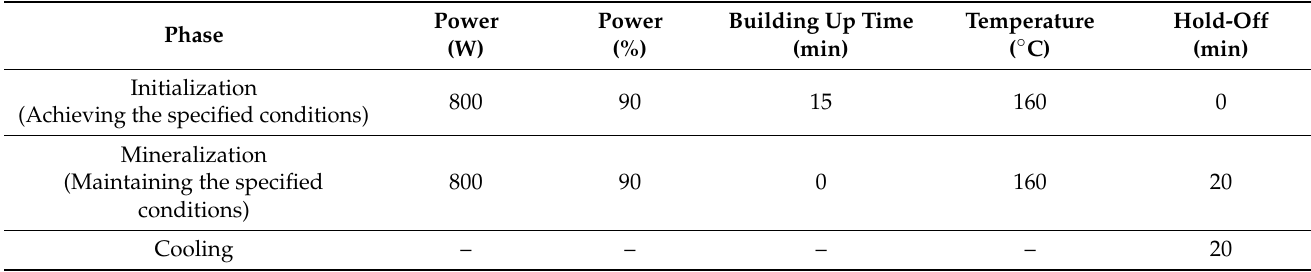
Table 2. Parameters of the mineralization